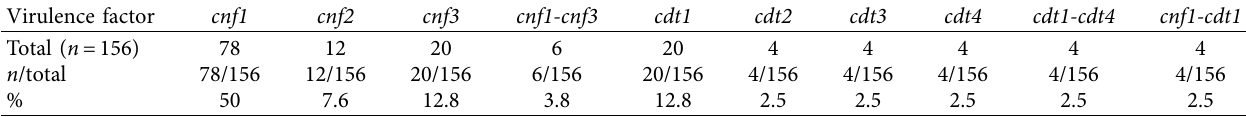
Table 4: Te distribution of toxin genes in CDT- and CNF -positive 156 ExPEC isolates. Virulence factor